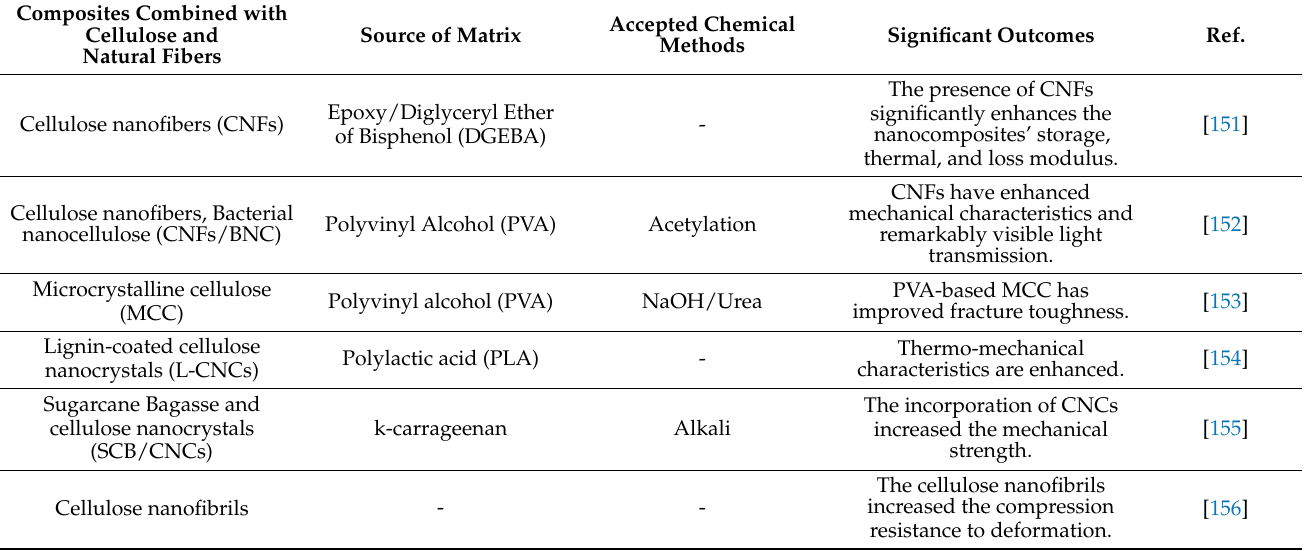
Table 1. The positive results of the nanocellulose-based